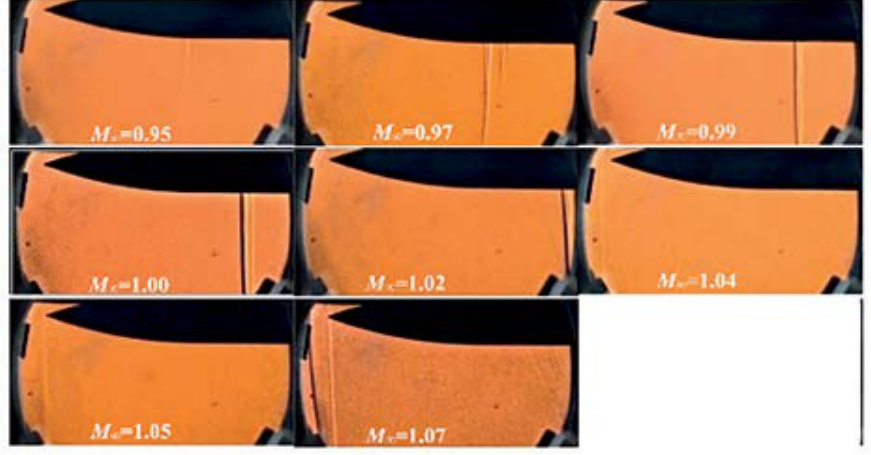
Figure 9. Schlieren images for model tangent–ogive forebody with a blockage area ratio of 0.78% for a stagnation pressure of 80 kPa and a stagnation temperature of about 300